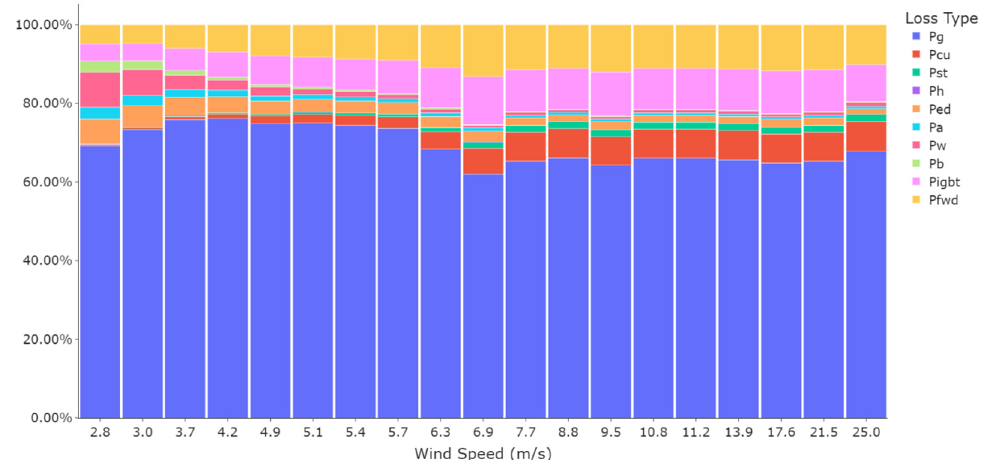
Figure 9. Distribution of the power loss in different stages of the indirect drive wind turbine.